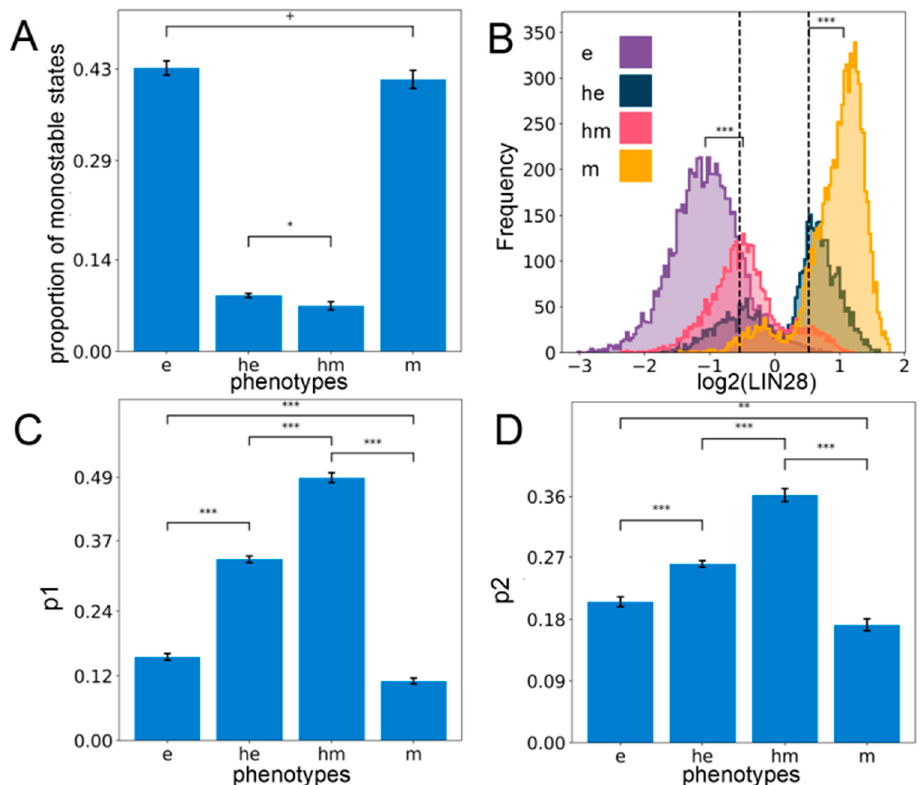
Figure 2. Hybrid E/M phenotypes are enriched for stemness. ( A ) Proportion of all monostable parameter sets belonging to different phenotypes—e, he, hm, m. ( B ) Expression histogram for LIN28 (all solutions of a single RACIPE replicate) for the four phenotypes with the stemness window (black vertical lines) as defined by the middle 30% of the “LIN28 biological range” (median ± one interquartile range averaged over n = 5 RACIPE replicates). Significance bars added to show statistically significant differences (Mann–Whitney U test) ( C ) Value of p1—the probability of a solution lying in the stemness window, conditional on the solution belonging to a particular phenotype for all the phenotypes ( n = 5 RACIPE replicates). ( D ) Same as ( C ) except for p2—the probability of a solution belonging to a particular phenotype conditional on it lying in the stemness window. For ( A , C , D ): Mean values show average across five RACIPE replicates and the error bars represent the across-replicate standard deviations. Two-tailed Student’s t -test with unequal variance (Welch’s t -test) was performed. Legend for the p -values: + p > 0.01, * 0.01 > p > 0.001, ** 0.001 > p > 0.0001, *** p < 0.0001; for effect sizes, refer to Table S7 in Supplementary Section S2.5.